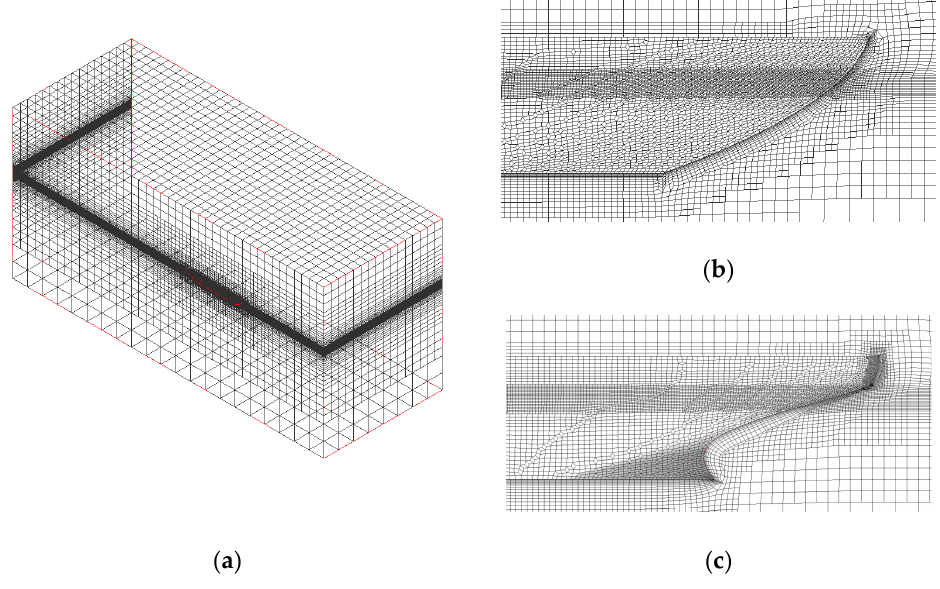
Figure 6. Ship hull mesh. ( a ) Grid of all areas, ( b ) Bow grid, ( c ) Stern grid.